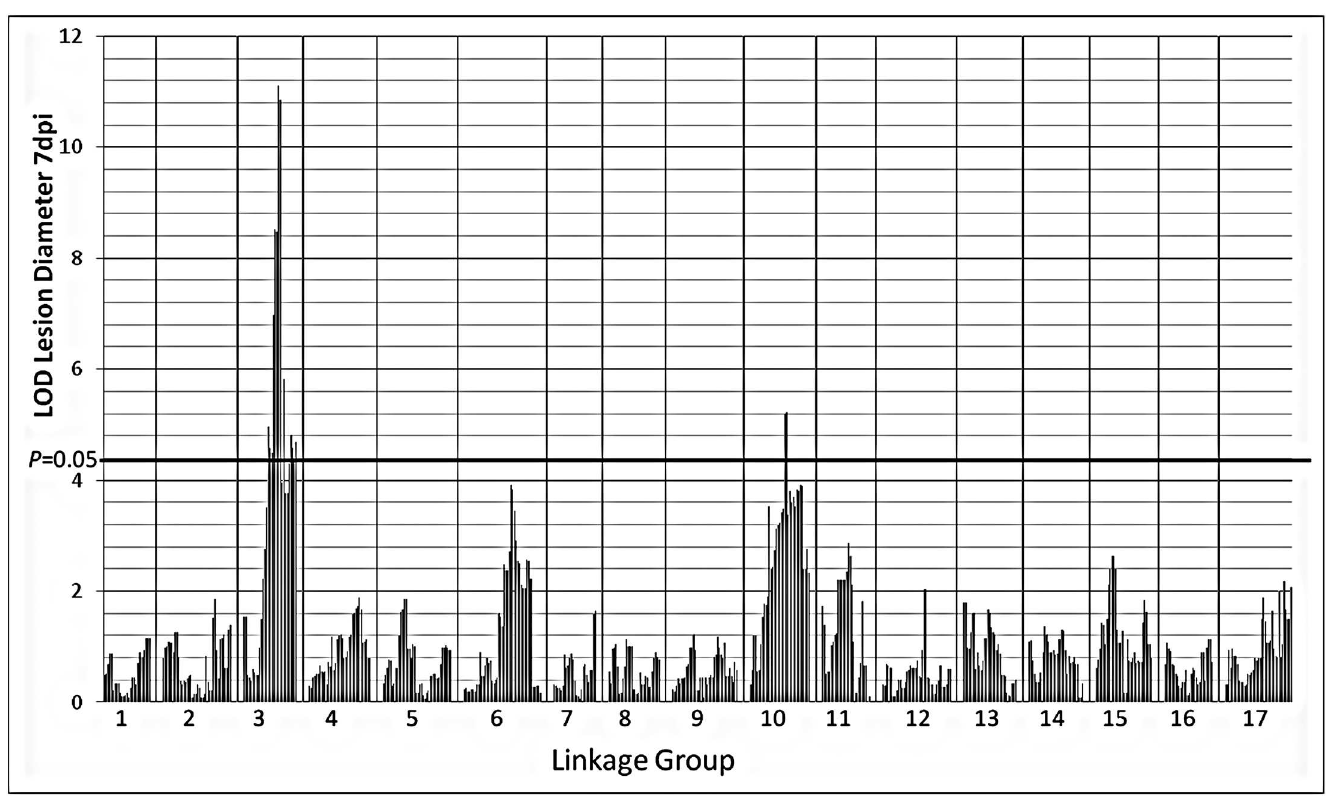
Fig 5. Manhattan plot of interval mapping LOD scores for the association between DNA markerintervals and observed blue mold lesion diameter 7 dpi in the GMAL4593 mapping population identified significant association with DNA markerson LG3 and LG10. The LSmeanof lesiondiameter 7 dpi was determined from combined2011, 2013and 2014 data. The genome wide P = 0.05 thresholdfor the data set was determinedto be LOD = 4.4 by a permutation test run (N = 1000) on the geneticlinkagemap consistingof SSR, SNPlex, HRM, and GBS markers; P = 0.05 threshold for LG3 = 2.8, LG6 = 3.0, and LG10 =